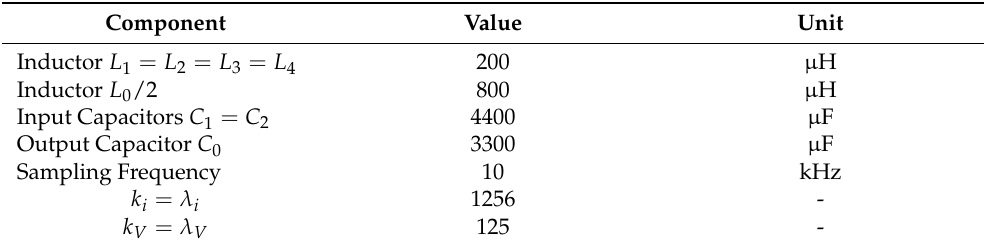
Table 1. Synthesis of the technical specifications and controller parameters of the studied